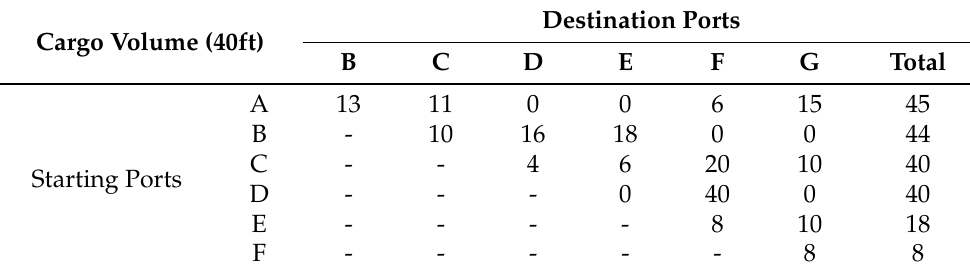
Table 4. Number of 40-foot export containers in each port (unit: FEU). Cargo Volume